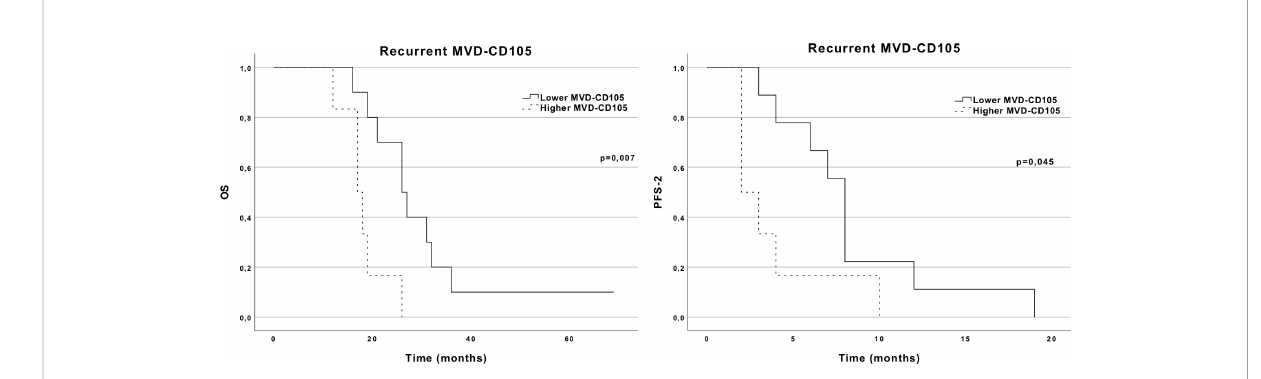
FIGURE 4 OS and PFS-2 Kaplan – Meier curves according to MVD-CD105 expression in the recurrent